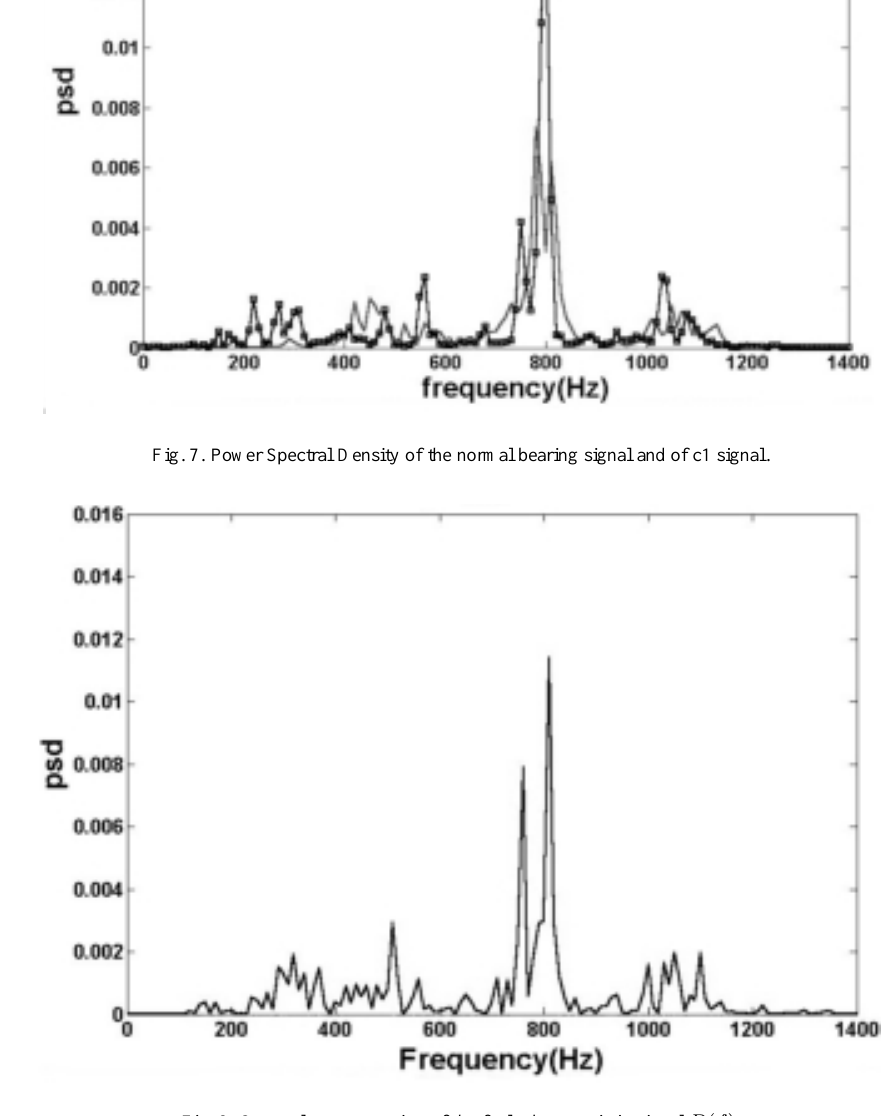
Fig. 8. Spectral representation of the fault characteristic signal D ( f )